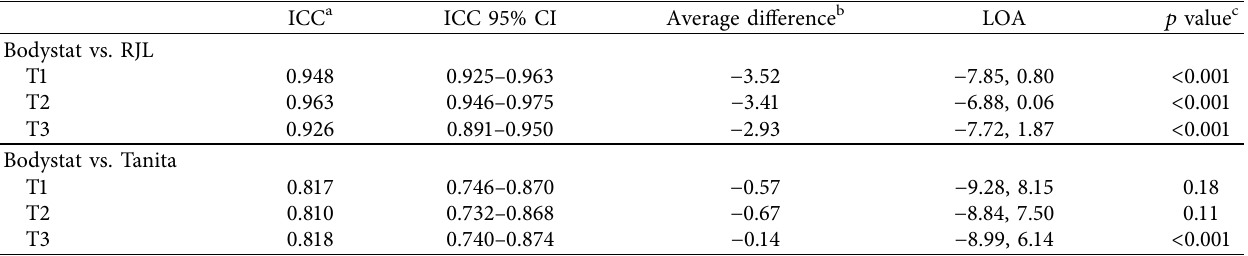
Table 2: Reproducibility in the method comparison of Bodystat, RJL, and Tanita for estimation of BFP.